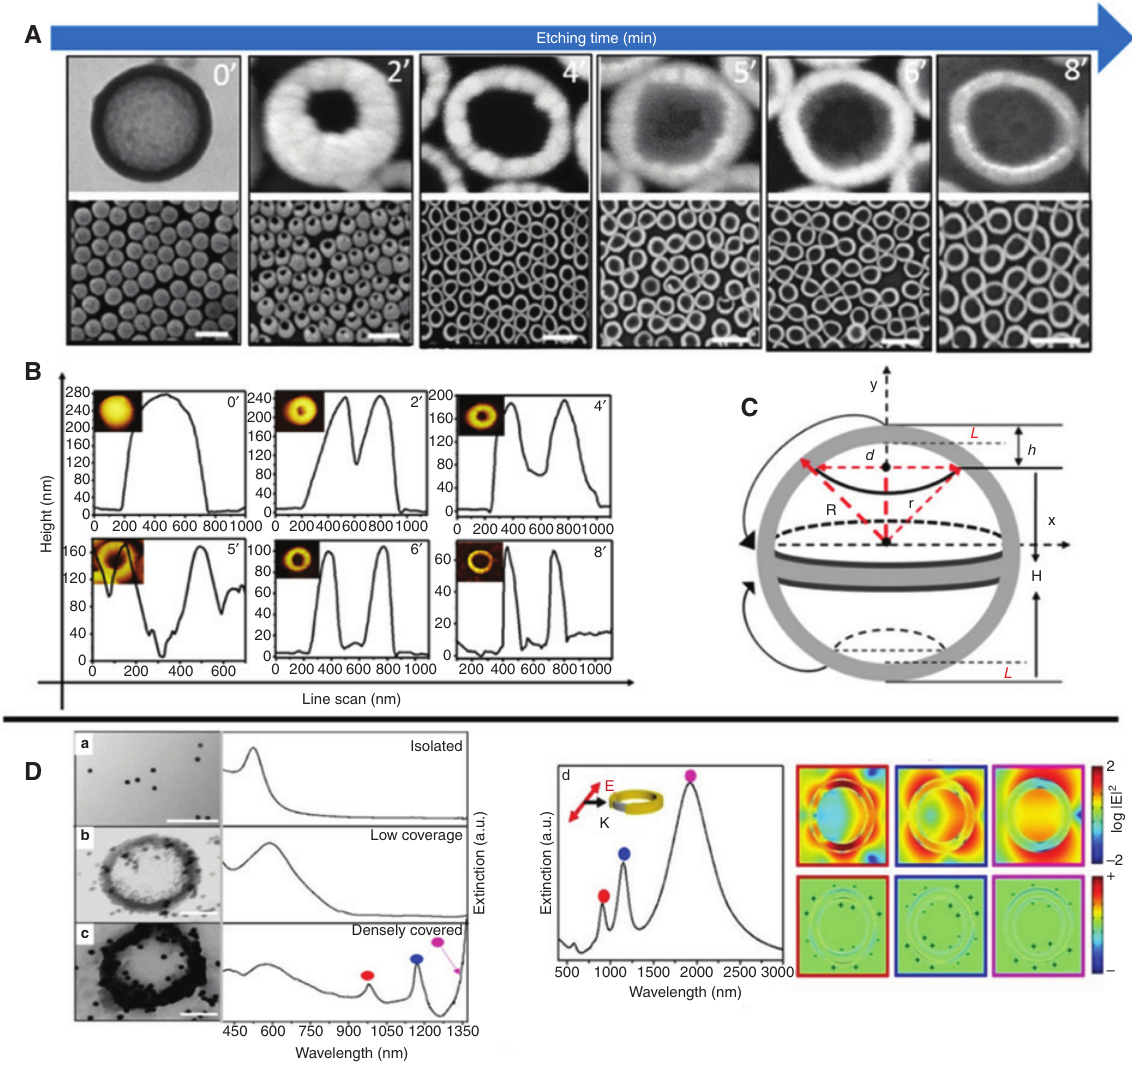
Figure 3: Direct fabrication of monodisperse silica nanorings from hollow spheres and their applications. SEM images (A) and AFM scans (B) showing the morphology changes from a hollow silica sphere to a ring-shaped nanostructure during the etching process. All scale bars are 500 nm. (C) Schematic of the geometrical parameters used to describe the changes of the hollow spheres during the etching process. (D) Left, the optical properties of silica-Au core-shell nanorings using the obtained monodisperse silica nanor- ings as template. Right, simulated extinction spectra and corresponding near-filed and charge density distribution of the silica-Au core-shell nanoring composite. Adapted with permission from ref. [108], COPYRIGHT 2016 American Chemical